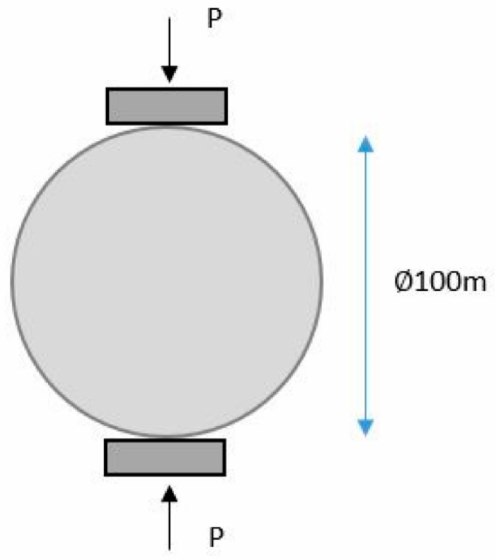
Figure 2. Schematic illustration of splitting test for concrete